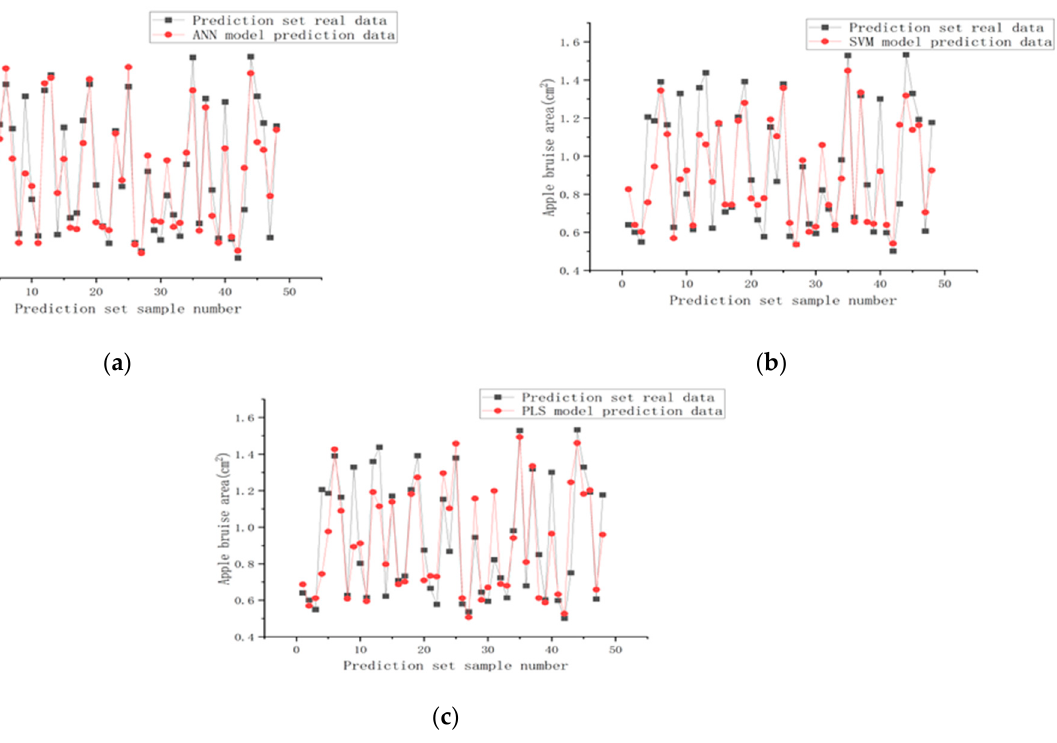
Figure 7. Apple bruise area regression results ( a ) the result plots of ANN model for apple bruise area prediction; ( b ) the result plots of SVM model for apple bruise area prediction; ( c ) the result plots of PLS model for apple bruise area prediction.